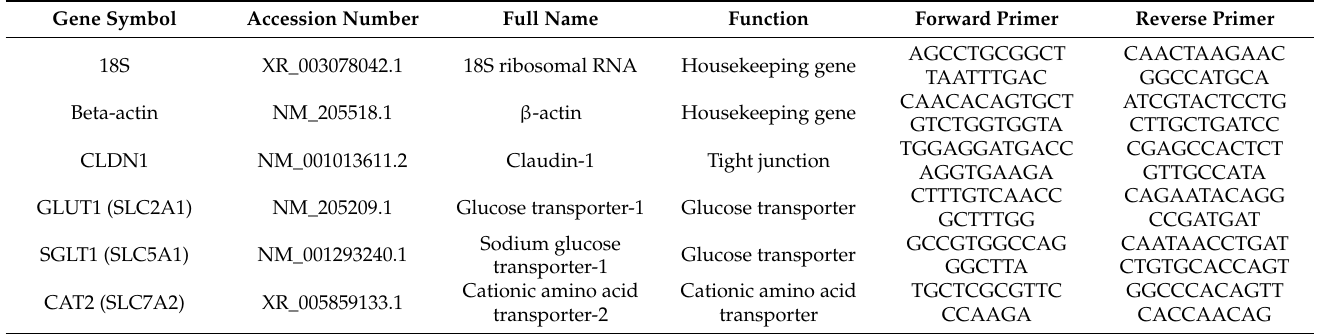
Table 4. GenBank accession numbers and sequences of forward and reverse primers used for real- time